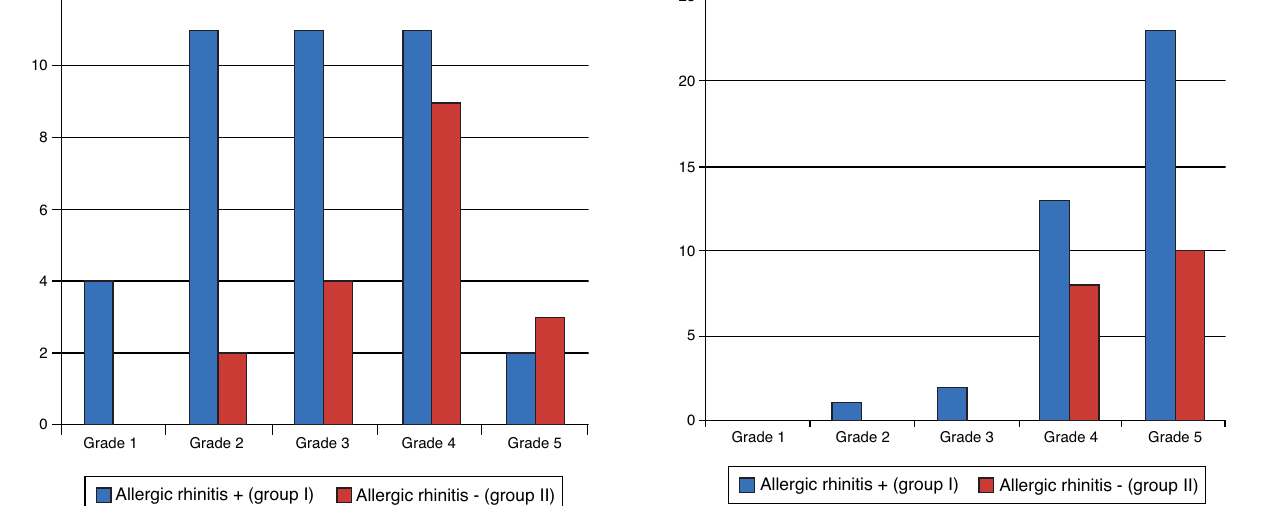
Figure 7 Degree of breathing improvement --- seventh day postoperatively.